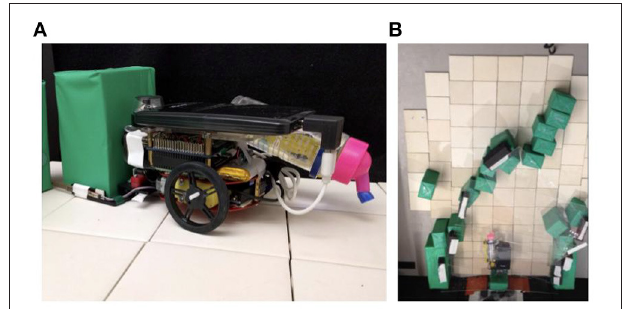
FIGURE 2 | Robophysical model. (A) Robot agent analogous to a termite, with gripper for manipulating blocks at left of image and dripper for water deposition on the right. (B) Overhead view of the arena after the robot has placed several